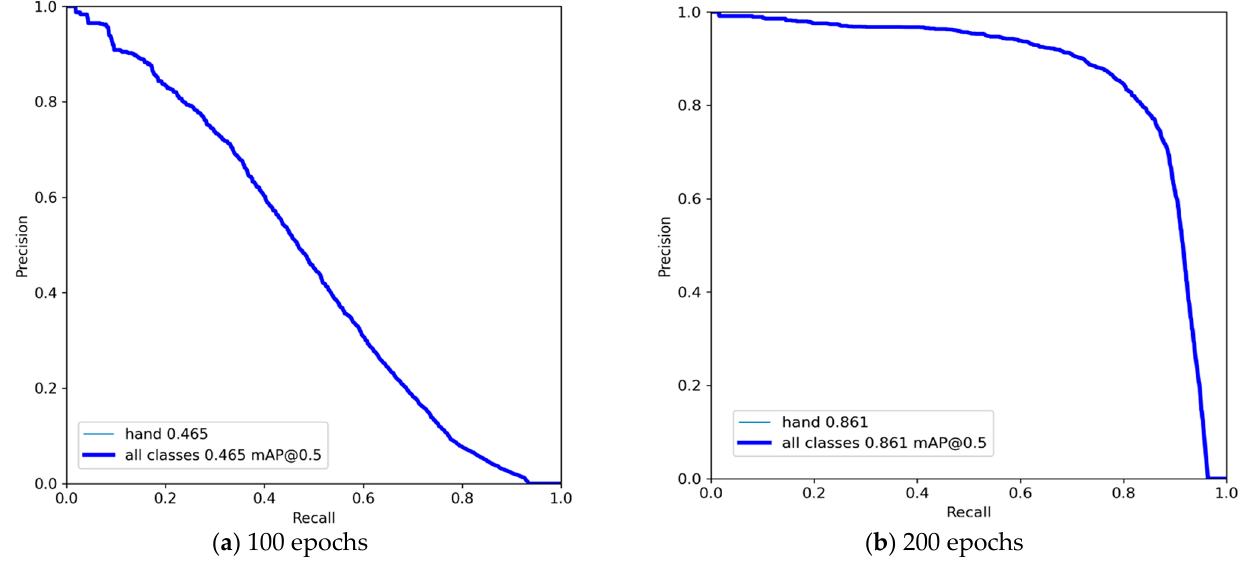
Figure 6. Precision and recall of Yolov7x with ( a ) 100 and ( b ) 200 epochs. Ultralytics has used the binary cross-entropy with the logits loss function that is offered in PyTorch for the purpose of calculating the amount of loss that has occurred in terms of both the class probability and the object score [39]. The true positive (TP) is the number of “yes”s in the real situation where the model evaluation is also a “yes”, and the true negative (TN) is the number of “no”s in the real situation where the model evaluation is also a “no”. The terms are abbreviated as “TP” and “TN”, respectively. A false positive (FP) occurs when the observed data do not match the predicted values from the model, while a false negative (FN) occurs when the observed data do match the predicted values from the model [40].